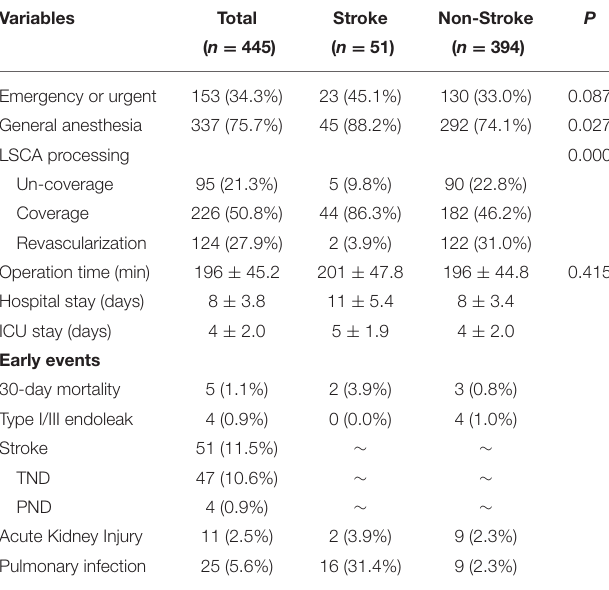
TABLE 2 | Operating data and early outcomes. TABLE 3 | Multivariate logistic regression for stroke after thoracic endovascular aortic repair for Stanford type B aortic